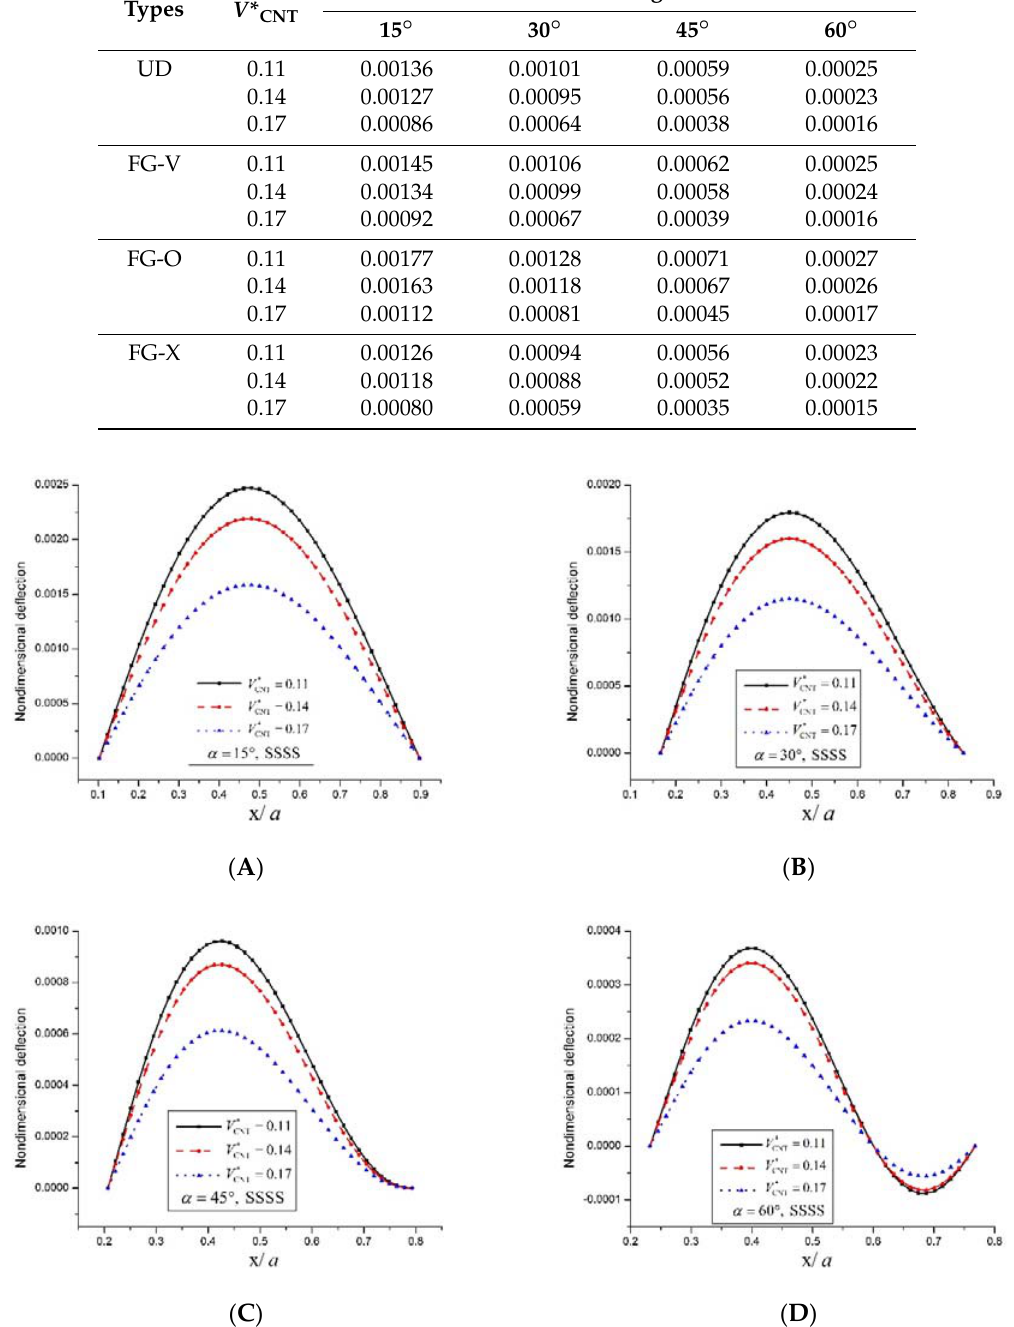
Figure 5. Non ‐ dimensional deflection of FG ‐ V CNT ‐ reinforced rhombic plate along the central line Figure 5. Non-dimensional deflection of FG-V CNT-reinforced rhombic plate along the central line for for ( A ) 15°; ( B ) 30°; ( C ) 45° and ( D ) 60° skew angle subjected to sin ‐ sin loading. ( A ) 15 ◦ ; ( B ) 30 ◦ ; ( C ) 45 ◦ and ( D ) 60 ◦ skew angle subjected to sin-sin